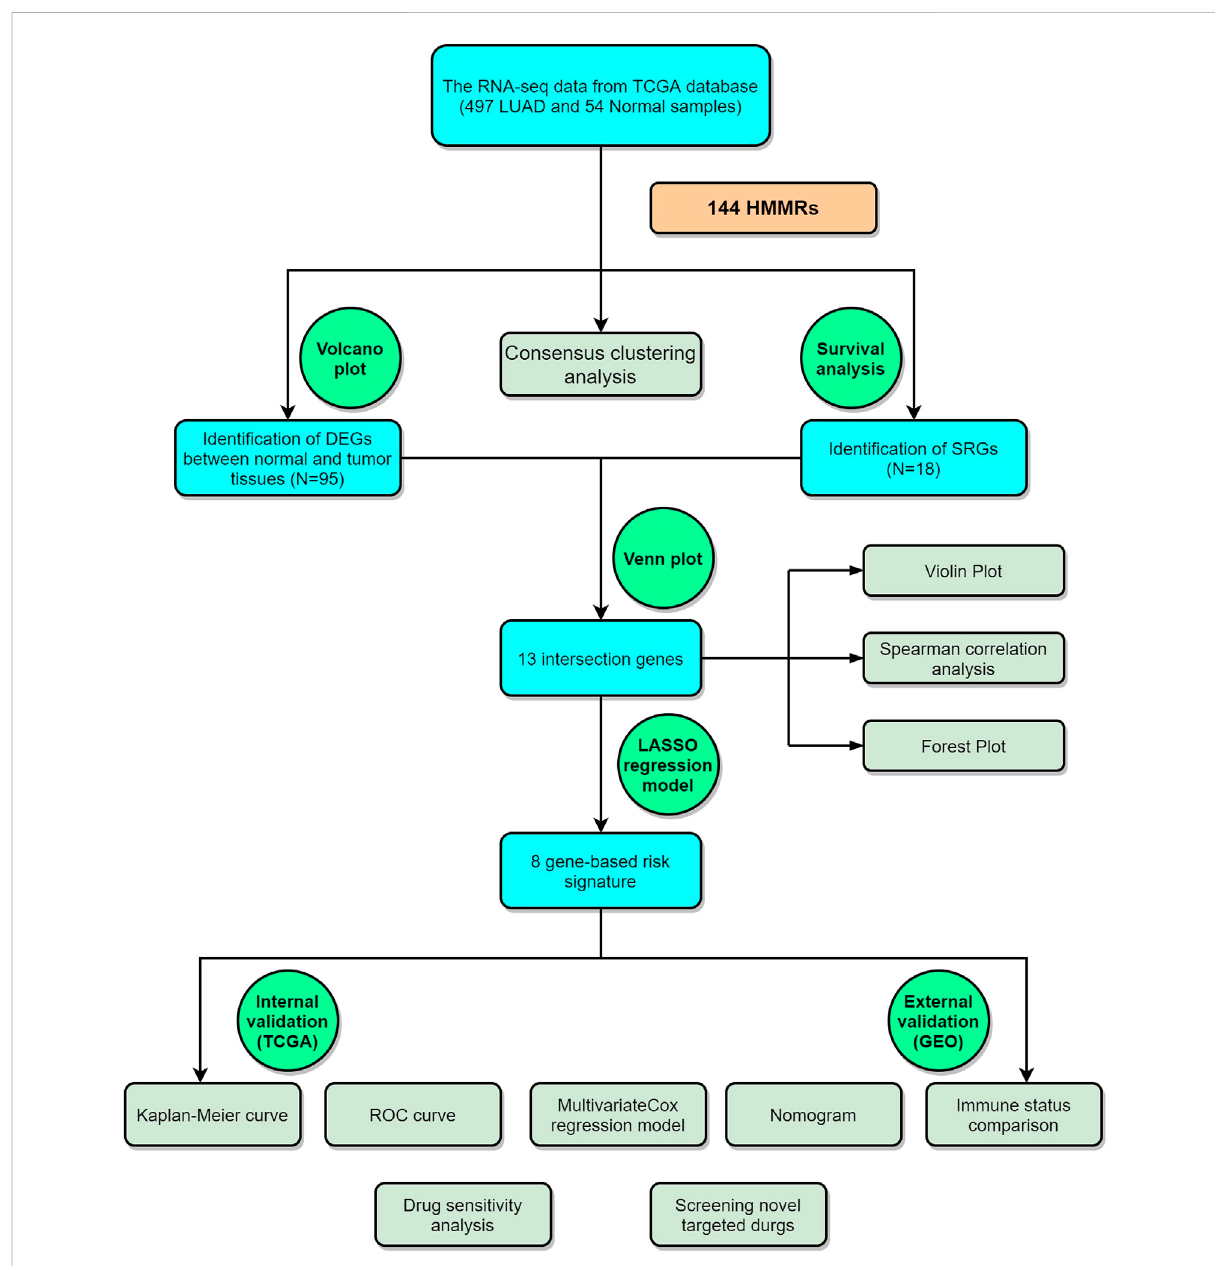
FIGURE 1 The graphical work fl ow maps of the